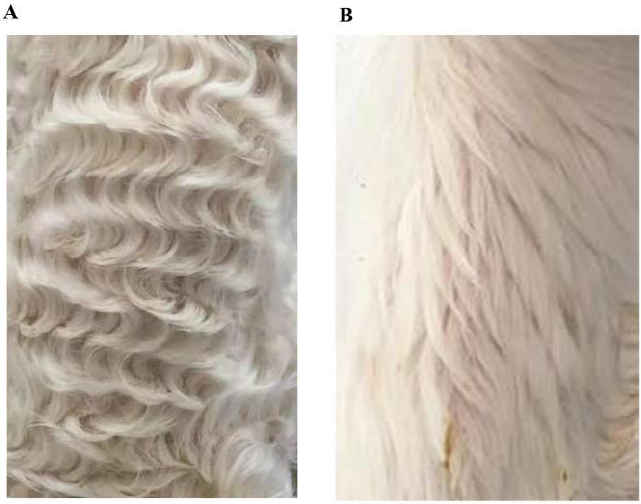
Figure 1. Identification of two pattern phenotype in Hu sheep. ( A ) Small waves. ( B ) Straight wool.